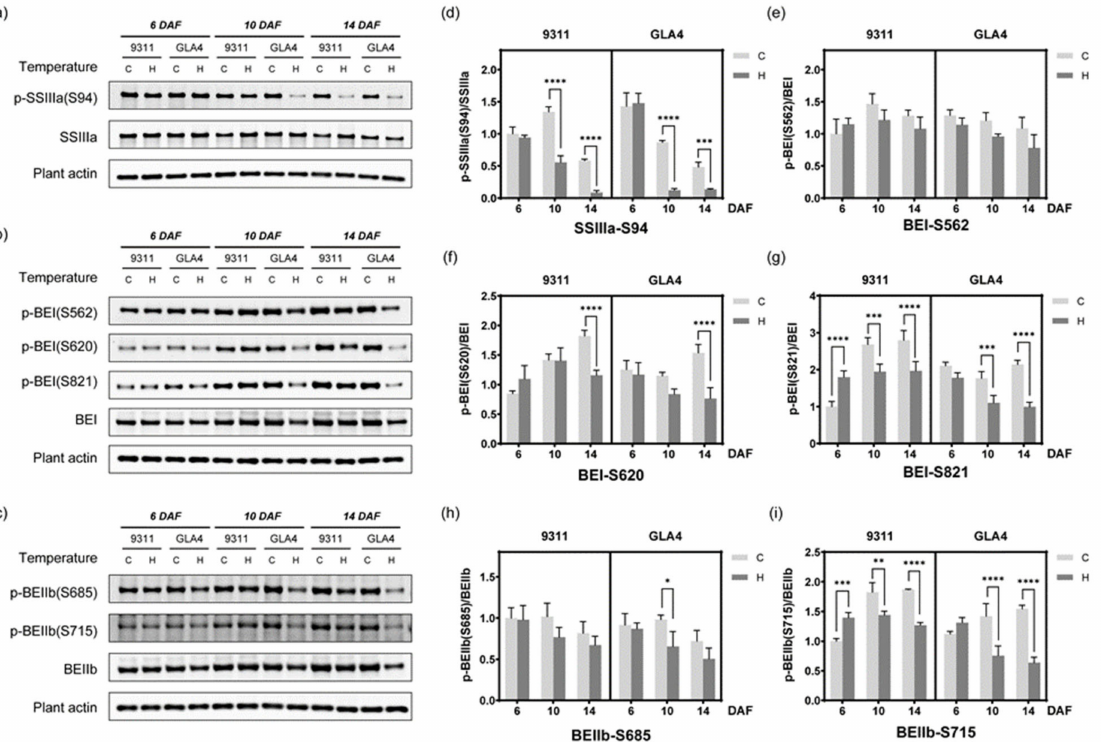
Figure 7. Western blot assay of some phosphorylated proteins. ( a – c ) Western blot assay of the phosphorylation of SSIIIa-S94, BEI-S562, BEI-S620, BEI-S821, BEIIb-S685, and BEIIb-S715. The best blot of three independent experiments is shown here. The results of the independent experiments followed a similar trend in expression. Uncropped gels are shown in Figure S19. ( d – i ) Evaluation of the relative phosphorylation intensity of starch-synthesis-related enzymes at the three grain-filling stages under high-temperature stress. * p < 0.05, ** p < 0.01, *** p < 0.001, and **** p <